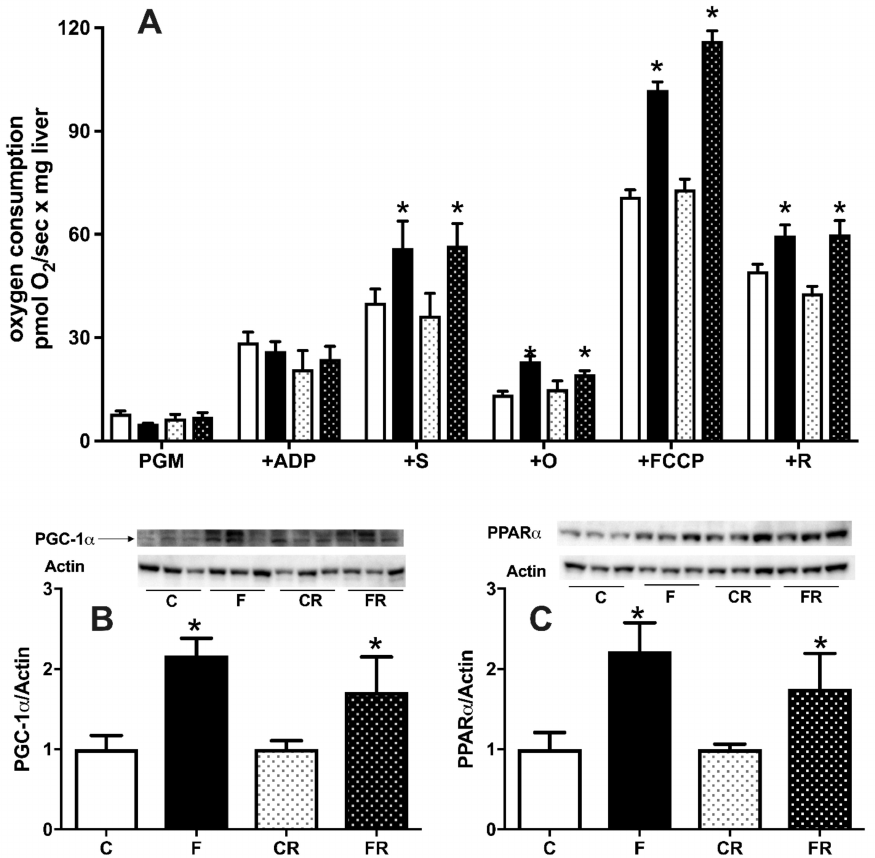
Figure 9. Hepatic mitochondrial respiratory activity ( A ), protein content (with representative west- ern blots) of peroxisome proliferator-activated receptor-gamma coactivator 1 alpha (PGC1 α ) ( B ), peroxisome proliferator activated receptor alpha (PPAR α ) ( C ) in control (C), fructose (F), control rescue (CR), and fructose rescue (FR) rats. Mitochondrial respiration (panel A) was measured in the presence of complex I-linked substrates pyruvate + glutamate + malate (PGM), adenosyntriphosphate (ATP), complex II-linked substrate succinate (S), ATP synthase inhibitor oligomycin (O), uncoupler carbonylcyanide p-trifluoromethoxyphenyl-hydrazone (FCCP) and inhibitor of complex I rotenone (R). Values are the means ± SEM of eight different rats. * p < 0.05 compared to respective control (one-way ANOVA followed by Tukey